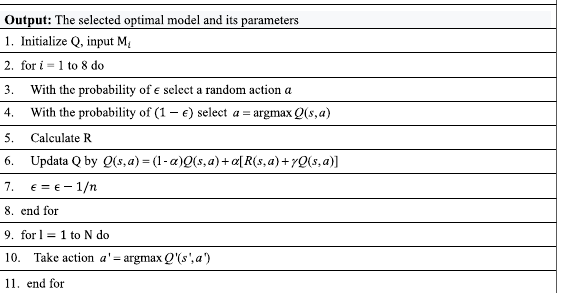
Algorithm 1. Q-learning model selection and parameter update